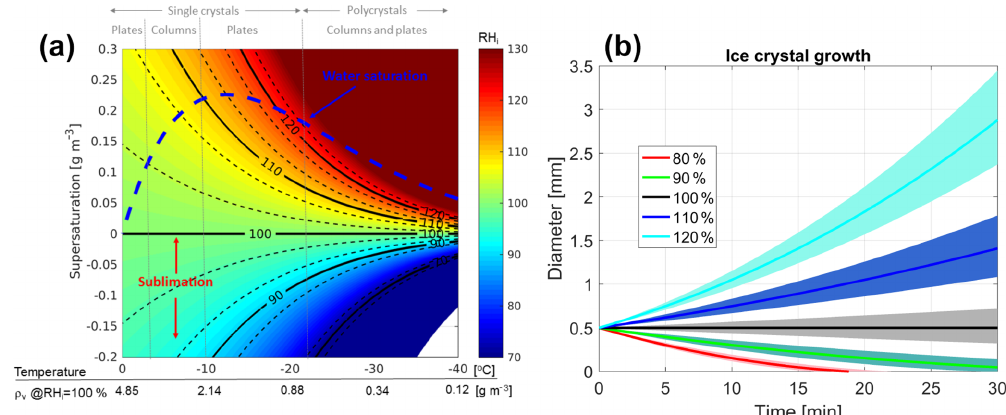
Figure 1. (a) Temperature in ◦ C vs. supersaturation in gm − 3 . The colour maps the relative humidity with respect to ice, RH i . The dashed blue line indicates the supersaturation of supercooled water relative to ice. Black lines correspond to different levels of RH i as indicated by the labels. The dashed lines surrounding each continuous line correspond to a ± 3% change in RH i . Some of the dominant ice crystal habits, as suggested by Bailey and Hallett (2009) for different environmental conditions, are indicated at the top of the figure. (b) Temporal evolution of the diameter of a 500µm crystal environment with different supersaturation RH i (as indicated in the legend) and at T = 260K and p = 500mb. The shading corresponds to a ± 3% perturbation in RH i . The rate of mass change is assumed to be driven by diffusional growth or sublimation (description provided in Field et al., 2008) with the Brown and Francis (1995) mass–size